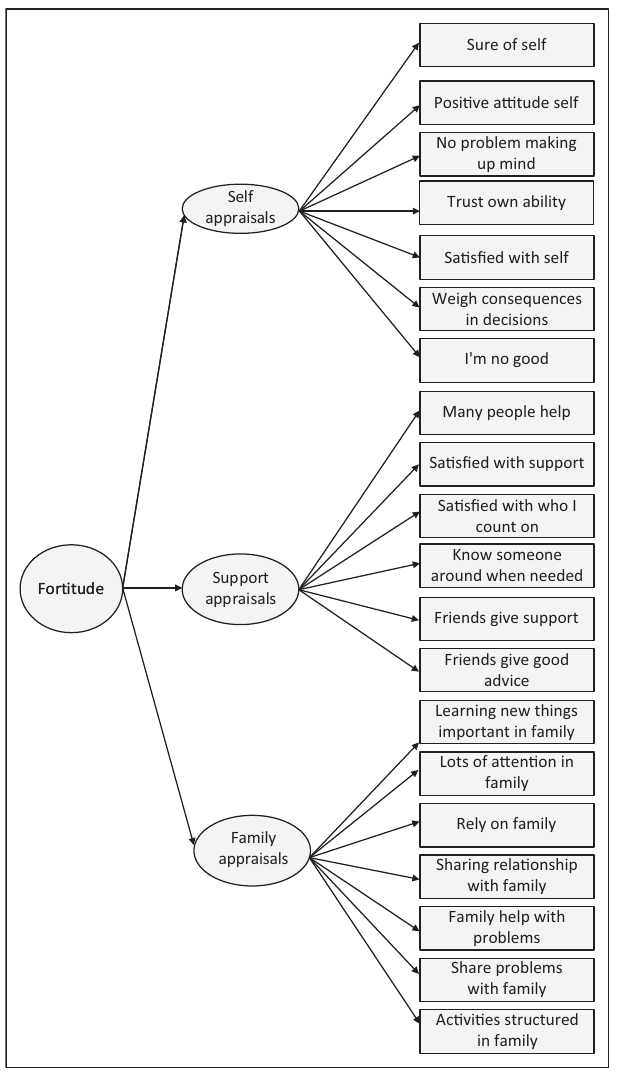
FIGURE 2: Three-factor higher order model of the factor structure of the Fortitude Questionnaire. Rectangles are the observed measurements (items), and ellipses are latent TABLE 1: Fit indices for two models of the structure of the Fortitude Questionnaire in three samples. Sample and models